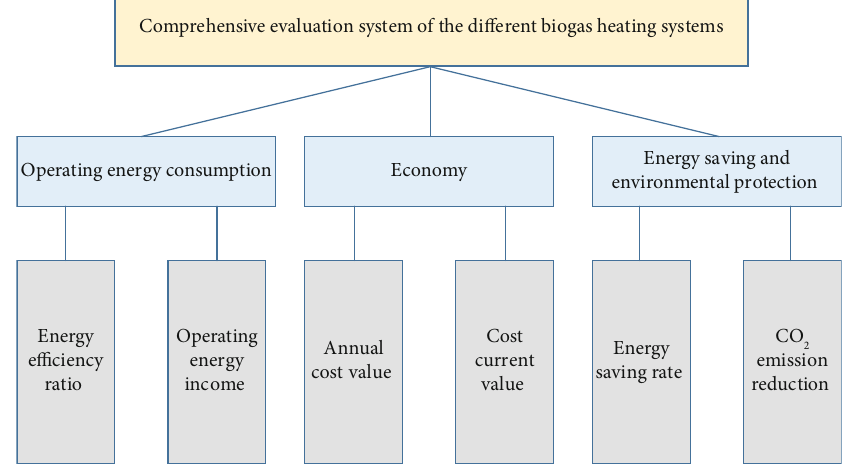
Figure 14: Comprehensive evaluation system for the di ff erent biogas heating systems. Table 7: EER and operating energy income for the di ff erent biogas heating